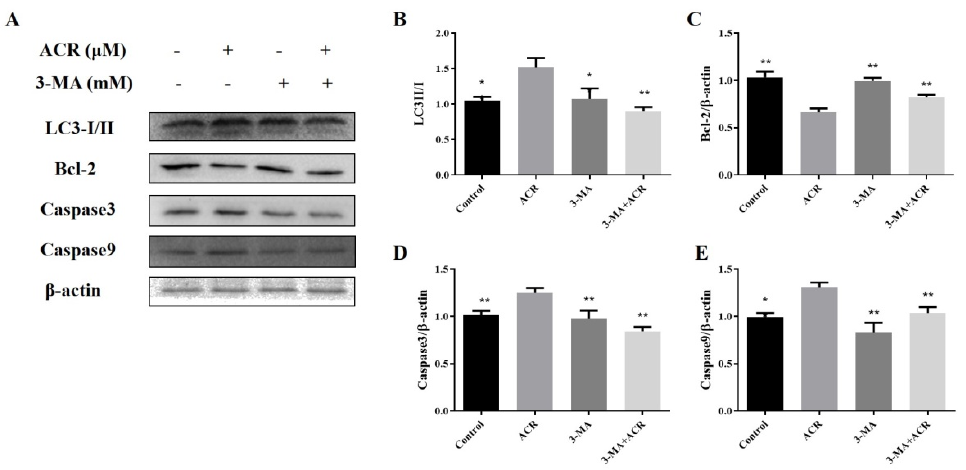
Figure 9. Autophagy inhibitor attenuated apoptosis. ( A ) The protein levels of LC3, caspase-9, caspase-3, and Bcl-2. ( B – E ) Relative intensities of these proteins. Values are means ± SD ( n = 3), * p < 0.05, ** p < 0.01 compared with the acrolein group. 3.10. The Effects of Apoptosis Inhibitor on IEC-6 Cell Autophagy In Figure 10B, treatment of IEC-6 cells with apoptosis inhibitors markedly inhibited the increase in acrolein-induced, apoptosis-related protein caspase-3. To verify the apoptosis inhibitor effect on cellular autophagy, we examined the expression of